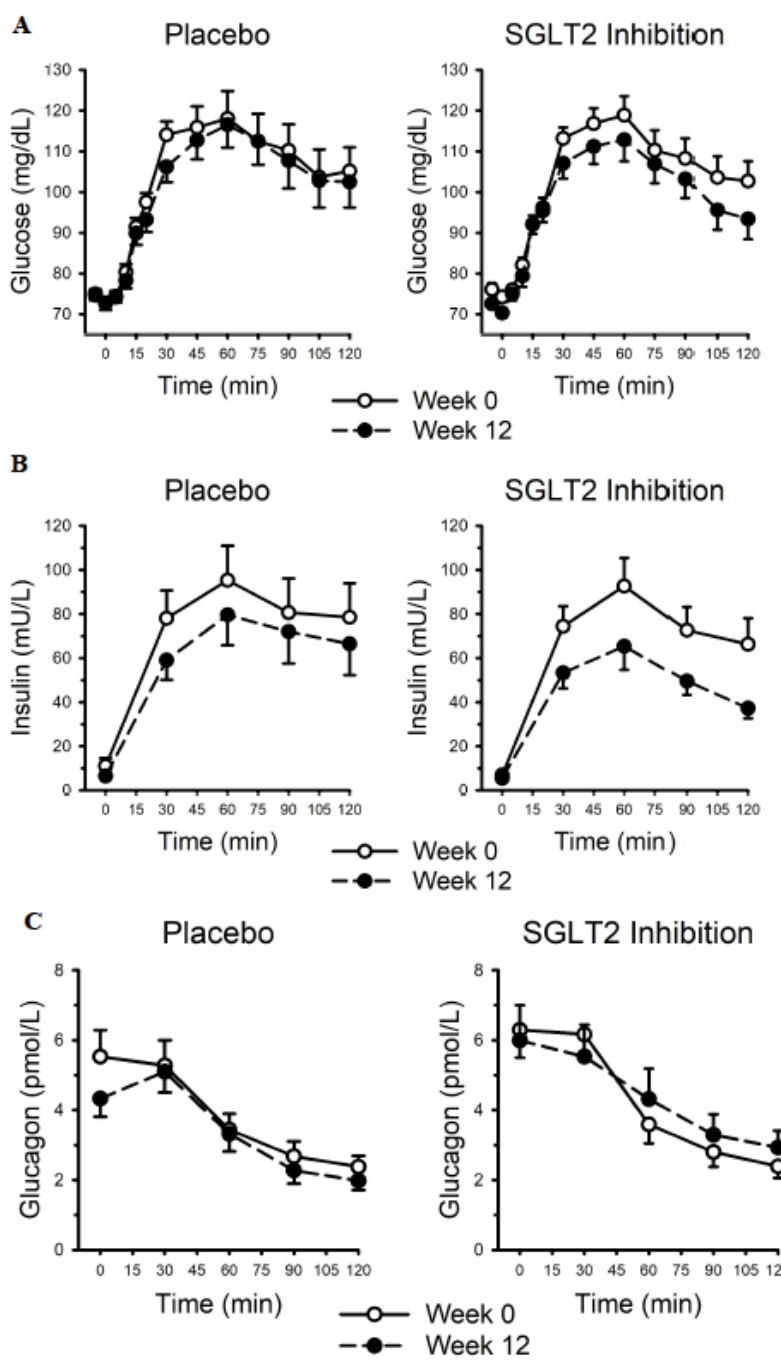
Figure 2. Circulating glucose ( A ), insulin ( B ), and glucagon ( C ) concentration during oral glucose tolerance testing prior to and following 12 weeks of dietary counselling for weight loss supplemented withplaceboorsodiumglucoseco-transporter2(SGLT2)inhibition. Comparedwithweek0, glucose was lower during the week 12 oral glucose tolerance test (OGTT; main e ff ect p = 0.004), but there was no group di ff erence (main e ff ect p = 0.458) or influence of SGLT2 inhibition (interaction p = 0.406). Overall, insulin was greater in the placebo group (main e ff ect p = 0.032), and compared with week 0, insulin was lower during the week 12 OGTT (main e ff ect p < 0.001); there was no influence of SGLT2 inhibition (interaction p = 0.382). On average, glucagon was greater in the SGLT2 inhibition group (main e ff ect p = 0.023) but was unchanged over 12 weeks (main e ff ect p < 0.582); SGLT2 inhibition did not influence this response (interaction p = 0.276). Data are mean and